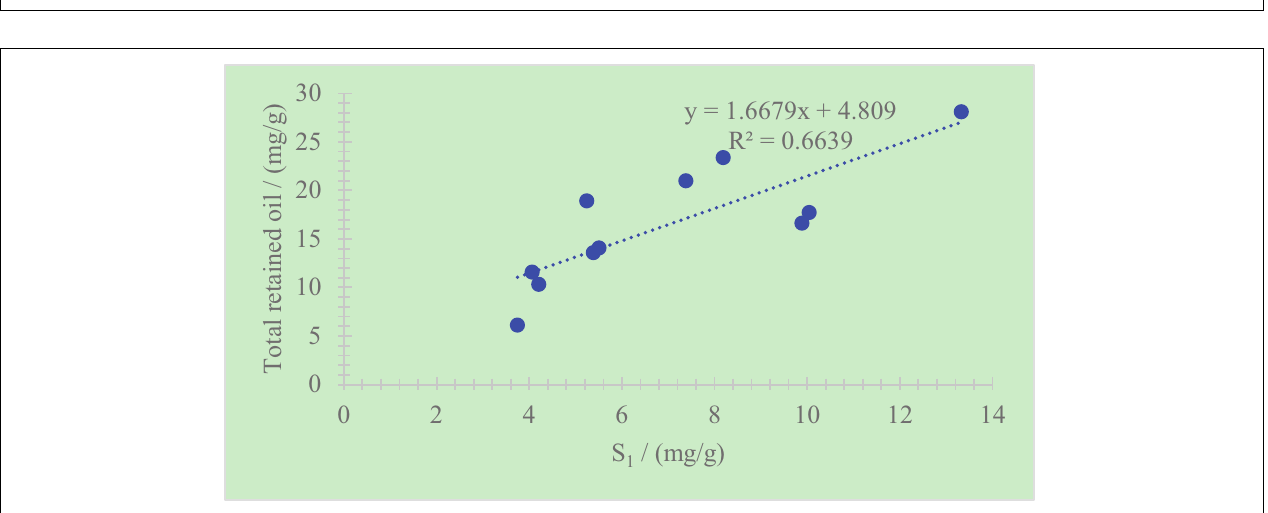
FIGURE 9 | Relationship between the total retained oil content and TOC.